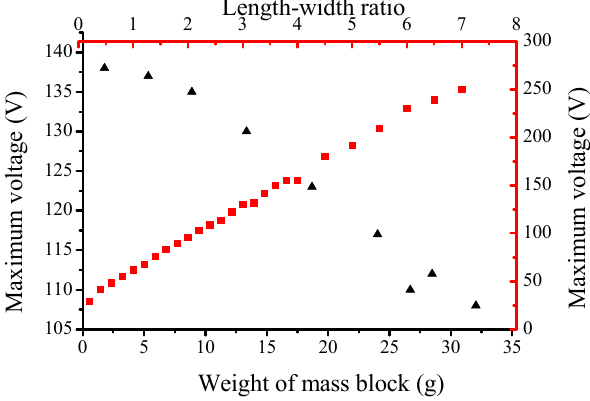
Figure 10. Weight of mass block and length ‐ width ratio versus maximum voltage in cantilever beam fixation mode.